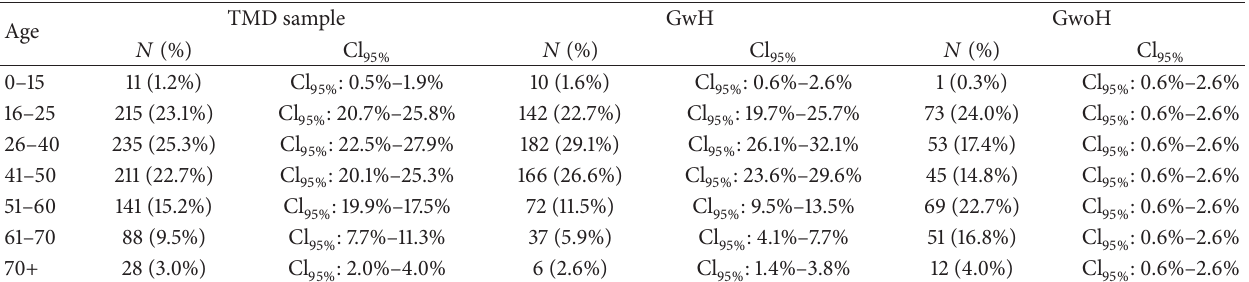
Table2:Absolutefrequency( 𝑁 )andpercentage(%)valuesofageintervalsinTotalDysfunctionalSample(TDS)andinGroupwithHeadache (GwH) and Group without Headache (GwoH).